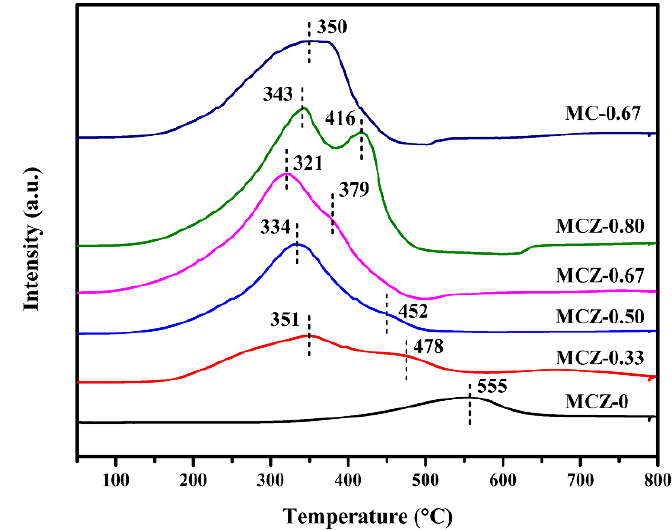
Figure 3. H 2 -TPR profiles of MCZ-x (x = 0, 0.33, 0.50, 0.67, 0.80) and MC-0.67 catalysts.